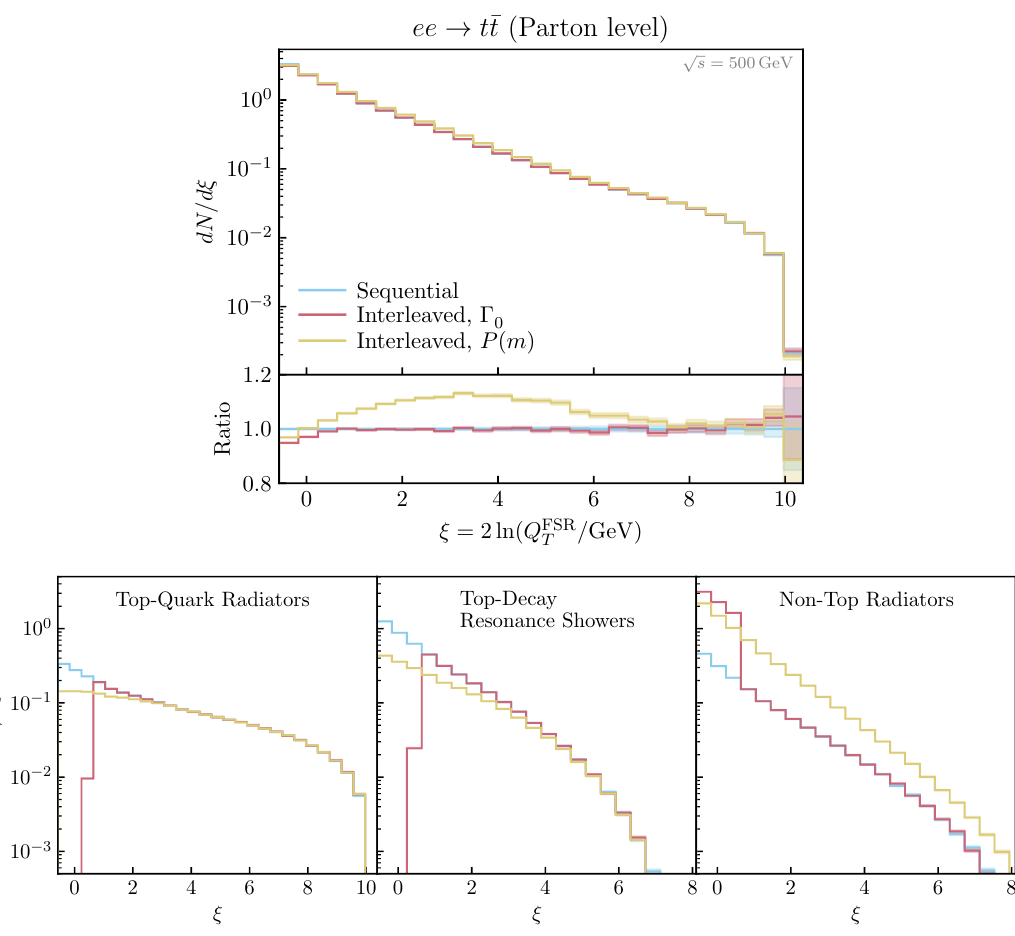
Figure 5: Vincia FSR branchings as functions of ξ = ln p 2 all radiators. Bottom Panes: separated into the three radiation classes described in the text. The colour coding in the bottom panes is the same as in the top pane. Here, and in future figures, shaded regions indicate statistical